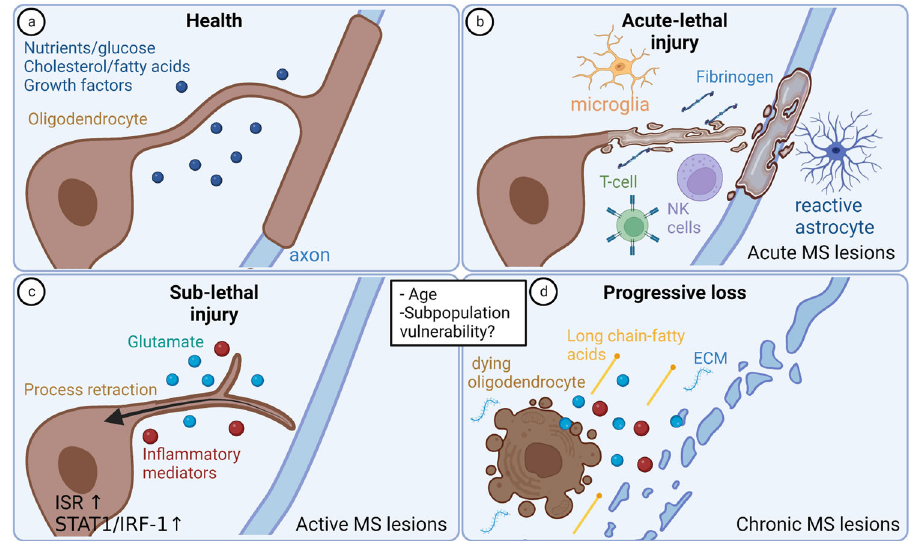
Fig. 2 OL injury in Multiple Sclerosis. a Oligodendrocytes in healthy conditions rely on nutrients (e.g., glucose), lipids (e.g., cholesterol, fatty acids), and growth factors to support their survival and myelination. b Acute-lethal injury is observed in acute MS lesions driven by cytotoxic T and NK cells (contact dependent), reactive astrocytes, microglia and increased fi brinogen. c Sub-lethal injury to oligodendrocytes in active MS lesions involves process retraction with retention of cell bodies, which can be reversed by returning them to optimal conditions. Important contributors to sub-lethal injury include metabolic stress, glutamate, and in fl ammatory mediators. Susceptibility to such injury may be in fl uenced by age, and oligodendrocyte subpopulations may be speci fi cally vulnerable. d Combination of insults and age can convert sublethal responses to progressive loss. Ongoing loss of oligodendrocytes is regulated via cell death mechanisms during disease progression, changes to the extracellular milieu such as modi fi cations to the extracellular matrix (ECM) and presence of cytotoxic long chain fatty acids. Created using